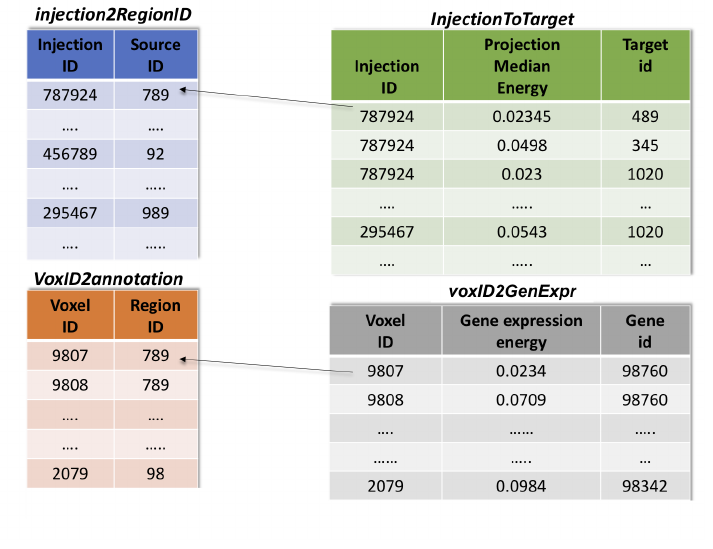
Figure 9. SQLite database tables generated to store all the gene expression and connectivity